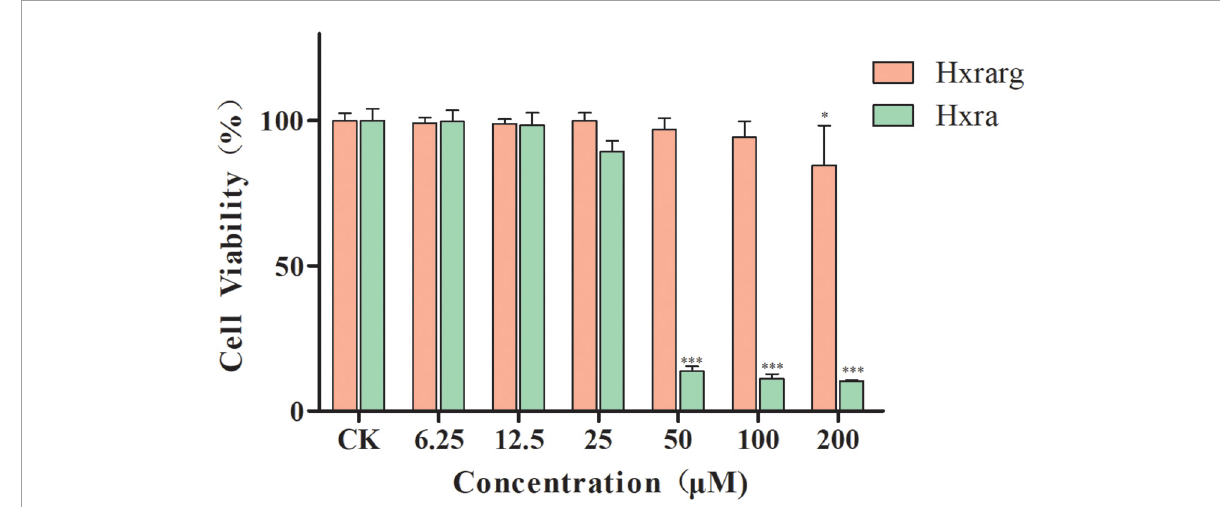
FIGURE2 Viability effect of Hxrarg and Hxra on 3T3-L1 preadipocytes. Compared with control group, ∗ P < 0.05, ∗∗∗ P < 0.001.